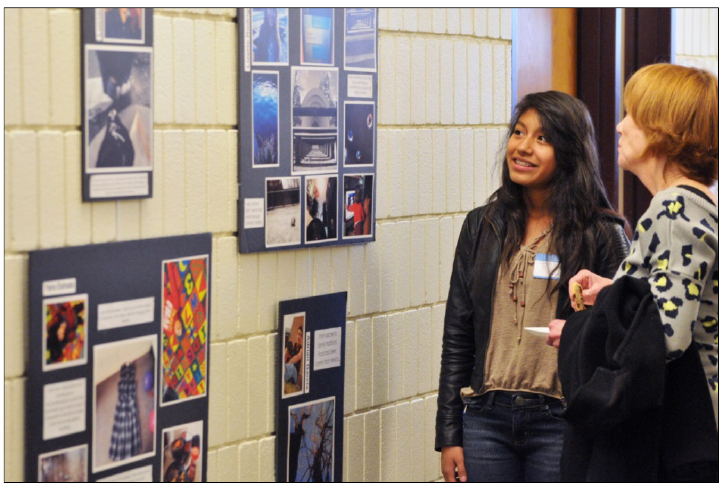
Figure 13. A YSI youth sharing her photographs with a visitor to the neighborhood photovoice opening (photo courtesy of Lynn M.